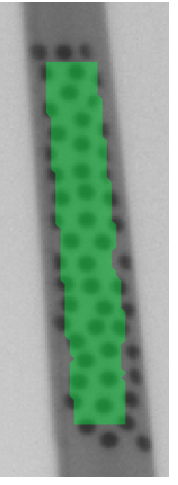
Figure 8. Measurement points plotted in 3D, not aligned to the ro- tor coordinate